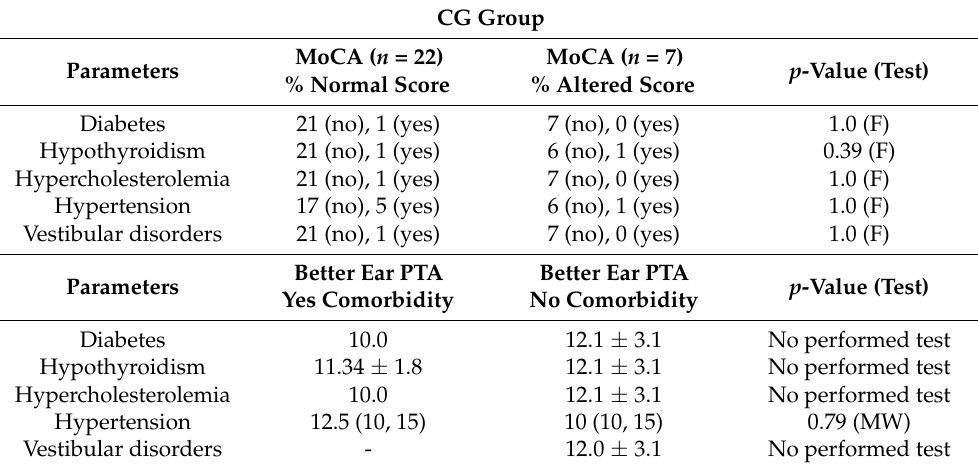
Table 5. Relationship analysis between the better ear PTA and MoCA parameter with comorbidities for the control